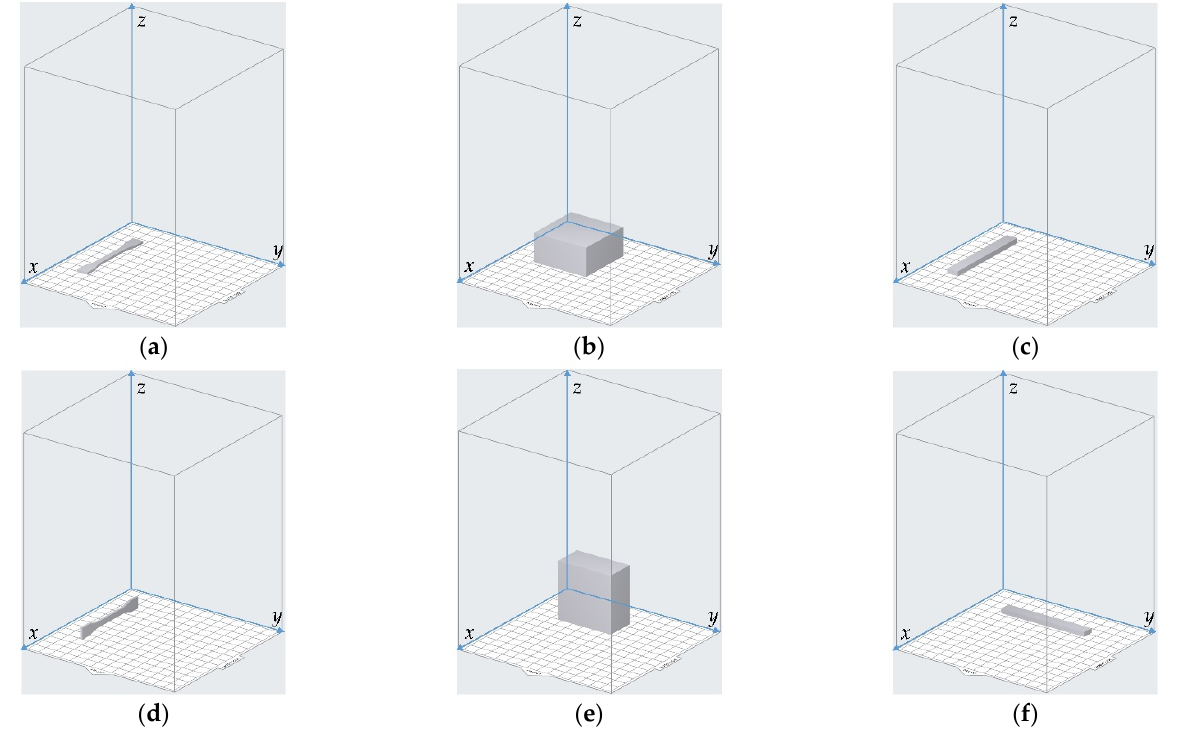
Figure 4. Adjustment of the printing orientations in the Preform software. ( a ) Default place of the sample for the detection of tensile strength; ( b ) default place of the sample for the detection of compressive strength; ( c ) default place of the sample for the detection of flexural modulus; ( d ) rotation 90° relative to the x –axis; ( e ) rotation 90° relative to the y –axis; ( f ) rotation 90° relative to the z –axis.